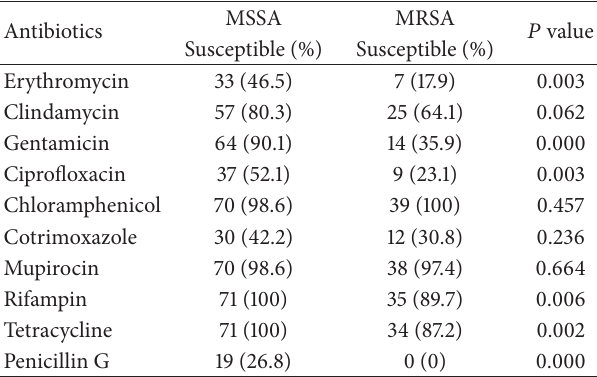
Table 2: Antibiotic susceptibility patterns of MSSA and